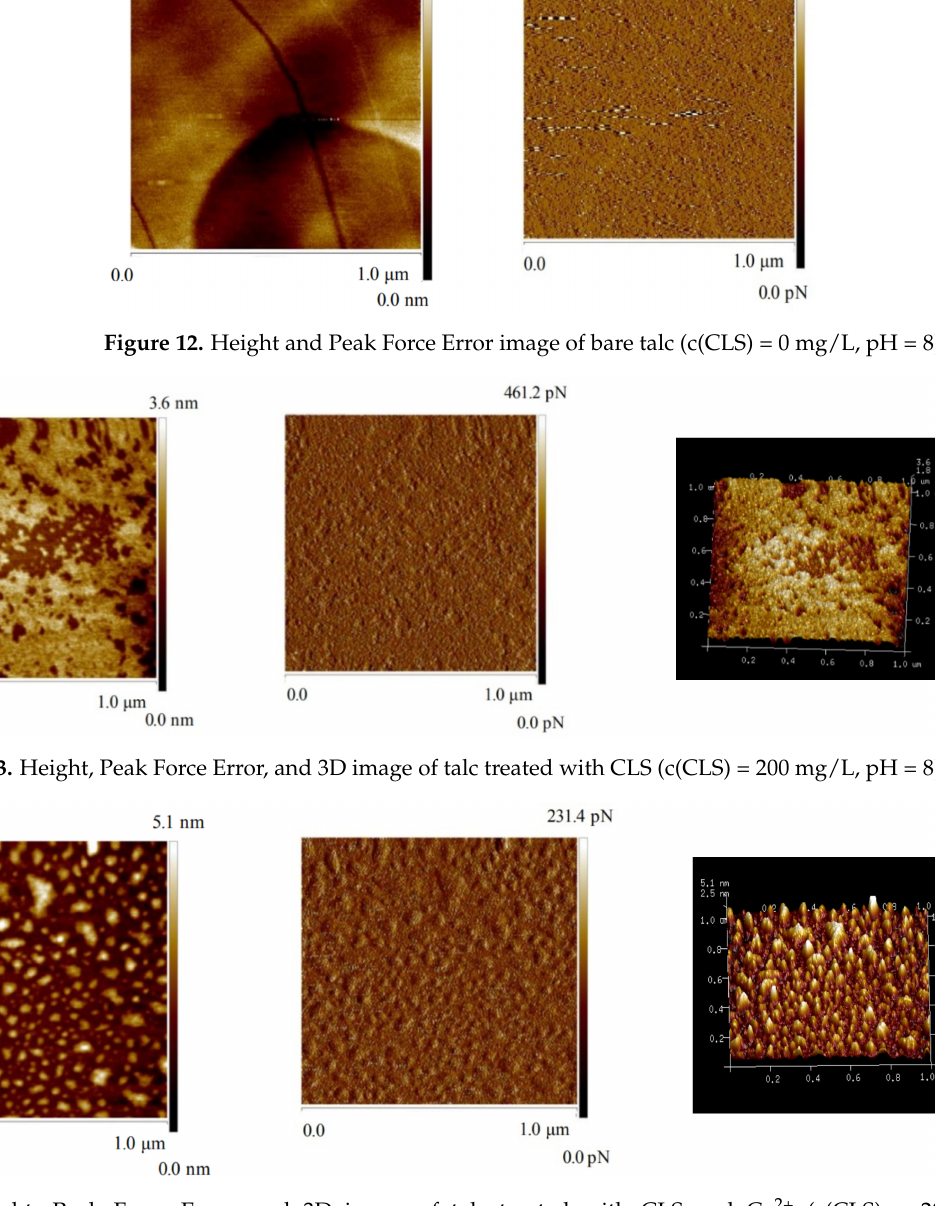
Figure 14. Height, Peak Force Error, and 3D image of talc treated with CLS and Ca 2+ (c(CLS) = 200 mg/L, c(Ca 2+ ) = 1 × 10 − 3 mol/L, pH =